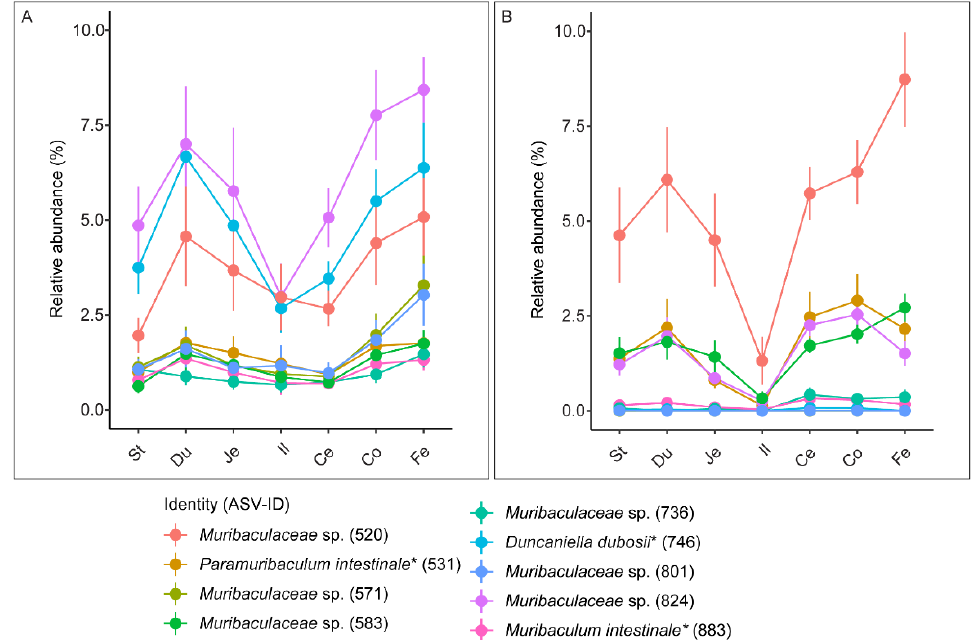
Figure 6. Relative abundance of nine Muribaculaceae ASVs along the gastrointestinal tract and feces. Shown are ASVs with ≥ 1% relative abundance in at least one segment/fecal group in ( A ) Control mice. ( B ) Treatment mice. Asterisks indicate ASVs with identical 16S rRNA genes to type strains. Error bars indicate standard error of the mean ( n = 12 except duodenum: control n = 11; ileum: control n = 11, treatment n = 10). St: stomach; Du: duodenum; Je: jejunum; Il: ileum; Ce: cecum; Co: colon; Fe: fecal.